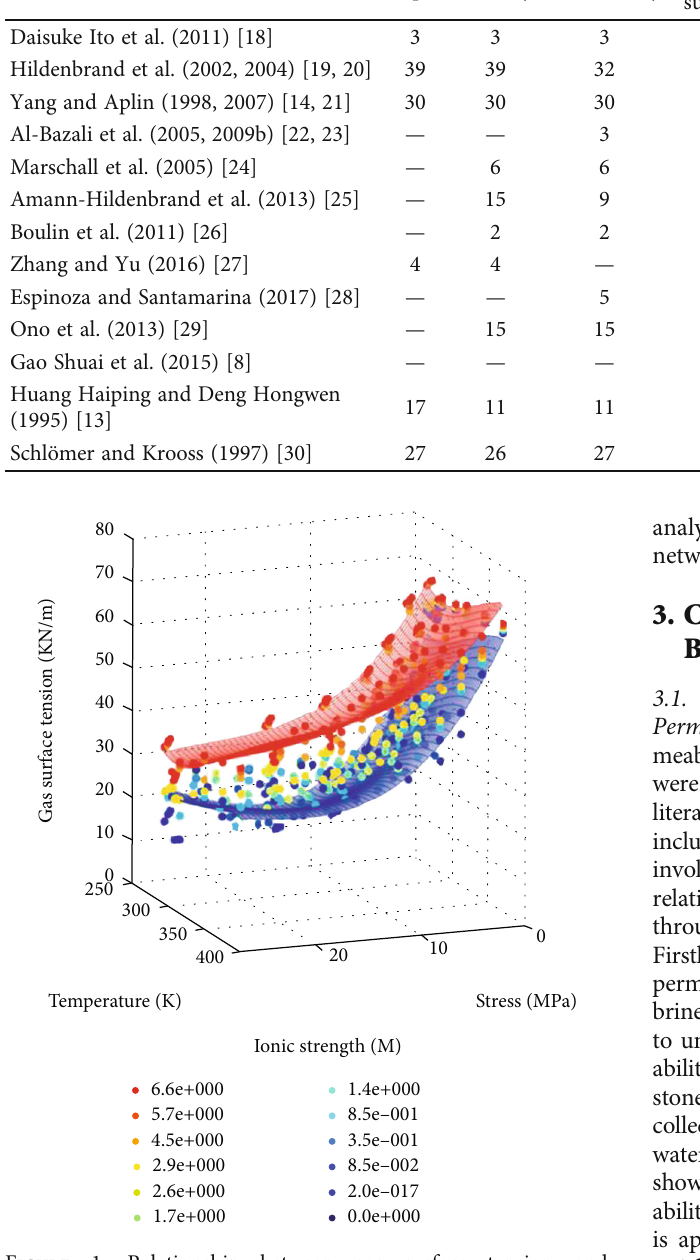
Figure 1: Relationship between gas surface tension and temperature, pressure, and ionic strength